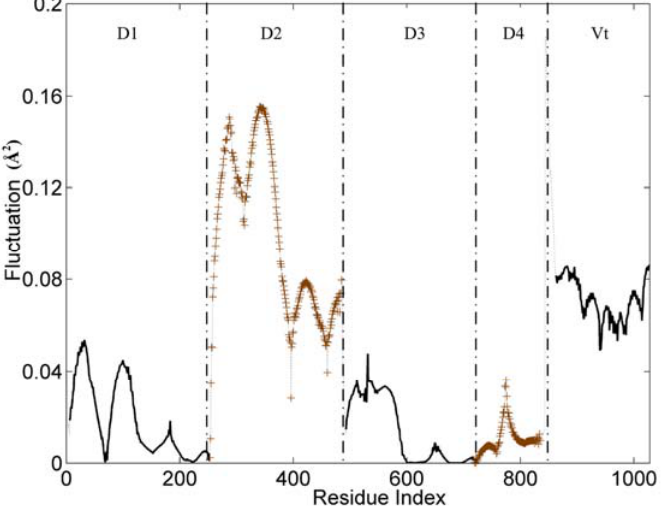
Figure 2. The slowest mode of vinculin structure (PDB ID: 1TR2, chain A). D2 and D4 domains are drawn with ‘+’ mark. D1, D3 and Vt domain are shown with an ordinary